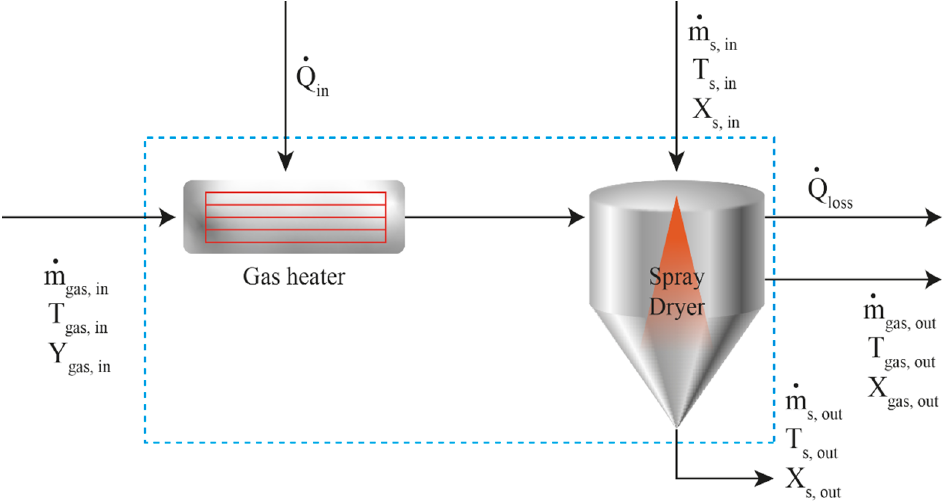
Figure 14. Schematic representation of mass, energy and enthalpy balances taking place in SD process: the drying medium flowing in at rate m gas,in is pre heated at duty Q in . The solids and liquid mixture enter the spray tower at rate m s,in . The outlet material flows at rate m gas,out and m s,out . The amount of Q loss is expended to the environment. The overall mass balance is calculated by the equation m gas,in + m s,in = m gas,out + m s,out.